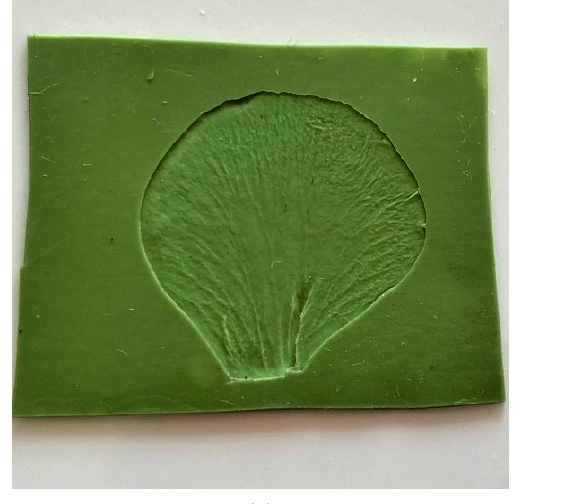
( b ) Figure 5. The surface of the crown leaves of the garden pansy (Viola x wittrockiana). ( a ) Overview microscopic image of a thin layer taken from the surface of the garden pansy crown leaf. ( b ) Detailed image of the surface of this layer with smooth sub-micrometer folds/protrusions. Reprinted from ref. [14,19,20]. 3. Results Figure 5a shows the top layer of surface cells located on the crown leaf of the garden pansy (Viola x wittrockiana). This layer contains a minimal amount of water, and thus the deformation of the conical formations during free drying in the air is negligible. In terms of morphology, the adaxial layer of the crown leaf of the garden pansy is formed by tightly arranged conical cells with dimensions at the hexagonal base of 30 to 40 μ m; the height of the cells is about 40 μ m. The conical cells have smooth folds on their surface (Figure 5b); the thickness and height range from 300 to 400 nm. These protrusions do not show any other substructure on their surface. Microscopic images of the elastomeric mold—negative replicas (Figure 6a) show a quality replication process. The mold consists of conical holes formed when the elastomer was applied to the surface of a fresh plant pattern. It is an observable protrusion of sub- micrometer dimension on the hole walls, copying the plant cell surface. The arrangement of individual surface cones, their connection, and their shape are captured. A detailed microscopic image shows that the surface of the mold protrusions is smooth (Figure 6b).